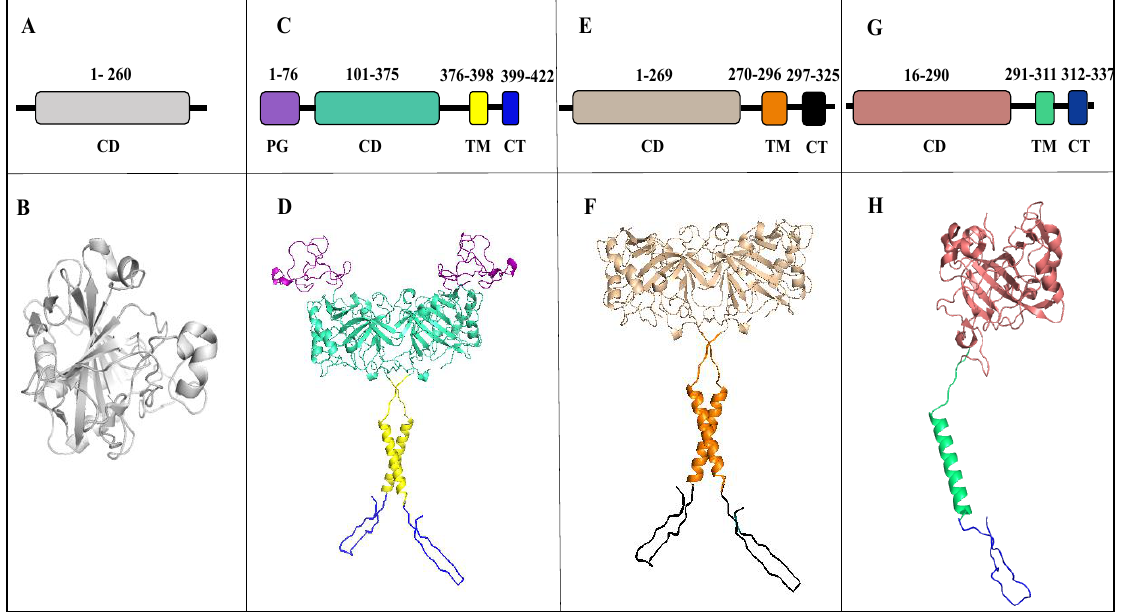
Figure 2. Schematic and structural representations of CA isoforms. Top panel: Schematic of domains ( A ) CA II: catalytic domain (grey), ( C ) CA IX: proteoglycan-like domain (PG, purple), catalytic domain (CD, cyan), transmembrane domain (TM, yellow) and C -terminal domain (CT, blue) ( E ) CA XII: catalytic domain (wheat), transmembrane domain (orange) and C -terminal domain (black) and ( G ) CA XIV: catalytic domain (salmon), transmembrane domain (green) and C -terminal domain (blue). Bottom panel: Cartoon representation of ( B ) CA II, ( D ) CA IX, ( F ) CA XII and ( H ) CA XIV.